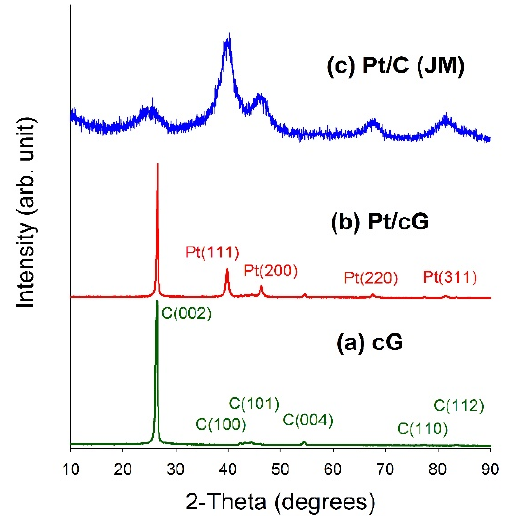
Figure 4. XRD patterns of the samples. ( a ) cG; ( b ) Pt/cG; ( c ) Pt/C (JM).